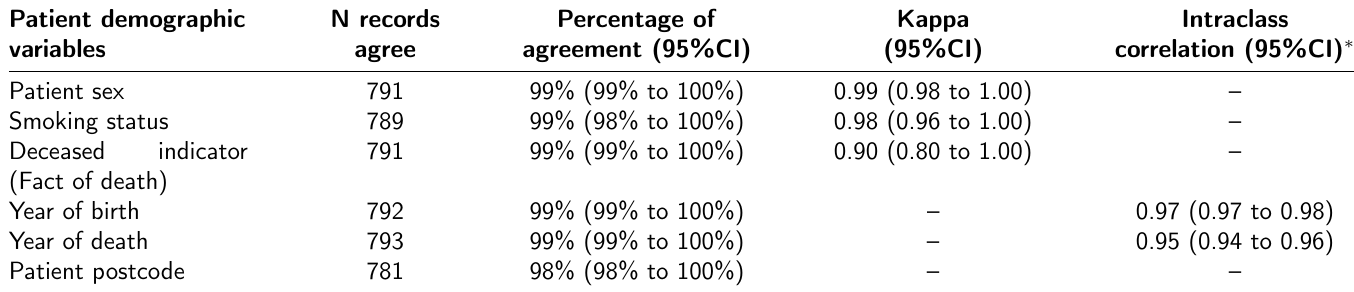
Table 3: Agreement between MedicineInsight and EHR data fields for patient demographics and risk factors Patient